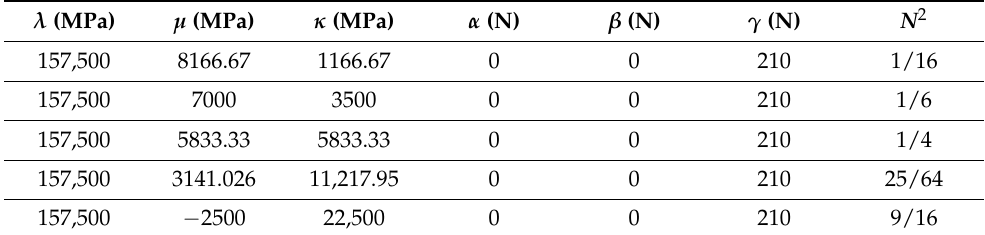
Table 1. Micropolar material constants adopted for the study of the influence of the coupling number.